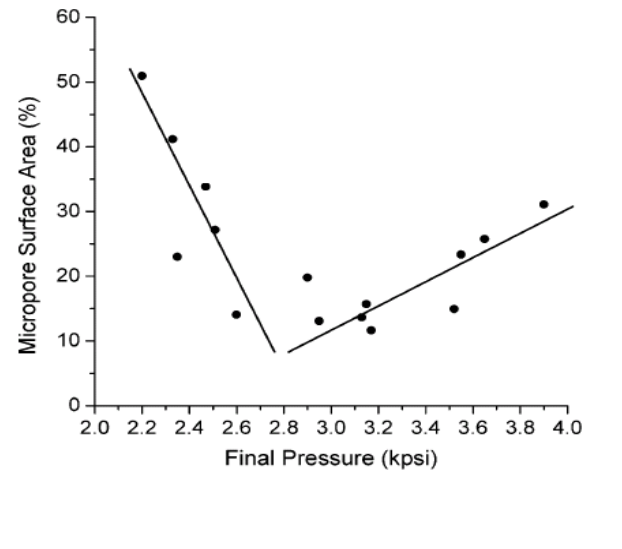
Figure 8. Variation of the percentage of micropore surface area ( i.e ., micropore area/total surface area × 100) of trimethylolpropane trimethacrylate as a function of the final pressure of CO . (Reprinted (adapted) with permission from [30]. Copyright 2004 American 2 Chemical